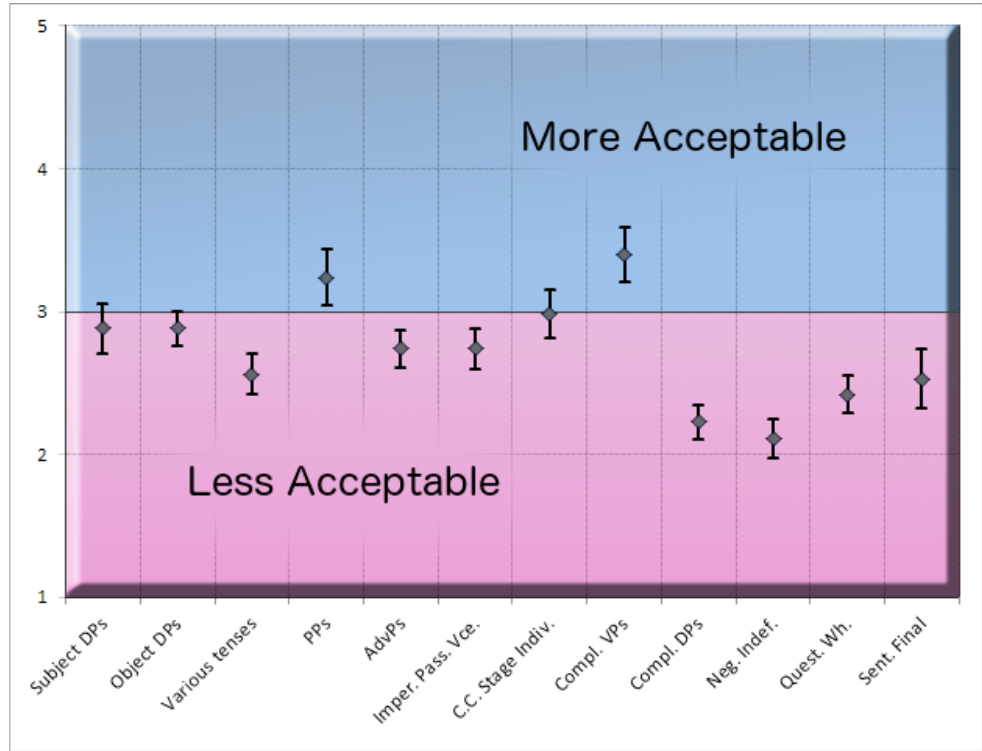
Graph 1: Mean scores for FS-focus categories given by all participants in the first test Graph 2 below indicates the average ratings for all categories of FS- sentences in each community. Again, speakers from both Santiago and